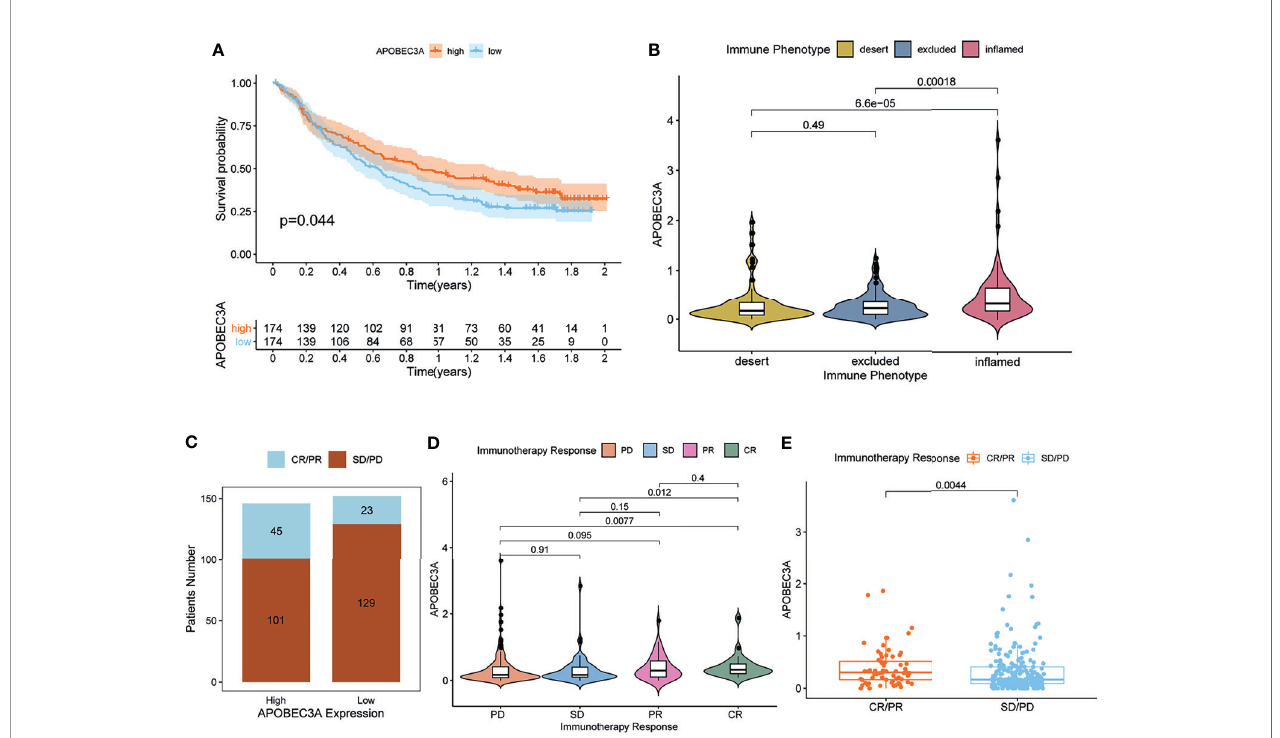
FIGURE 6 | APOBEC3A in the role of anti-PD-L1 immunotherapy. (A) Survival analyses for high (174 cases) and low (174 cases) APOBEC3A expression patient groups in the anti-PD-L1 immunotherapy cohort using Kaplan – Meier curves (IMvigor210 cohort; p = 0.044, Log-rank test). (B) Differences in APOBEC3A among distinct tumor immune phenotypes in the IMvigor210 cohort. The lines in the boxes represented median value (by Kruskal – Wallis test). (C) The number of patients with response to PD-L1 blockade immunotherapy in high or low APOBEC3A expression groups. SD, stable disease; PD, progressive disease; CR, complete response; PR, partial response. Responser/Nonresponer: 45/101 in the high APOBEC3A expression groups and 23/129 in the low APOBEC3A expression groups. (D) Distribution of APOBEC3A in distinct anti-PD-L1 clinical response groups. (E) The correlation of APOBEC3A with immunotherapy response, Wilcoxon rank sum was applied for the signi fi cance